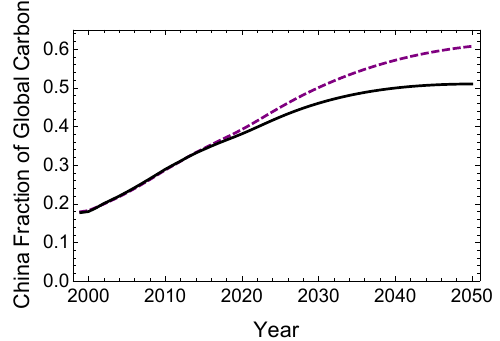
Figure 1. Fraction of global carbon emissions rate from China, Mongolia, and North Korea, extrapolated from historical data without (dashed curve) and with an assumption that this region’s long-term limit per capita GDP is equal to the limit for the USA region (solid